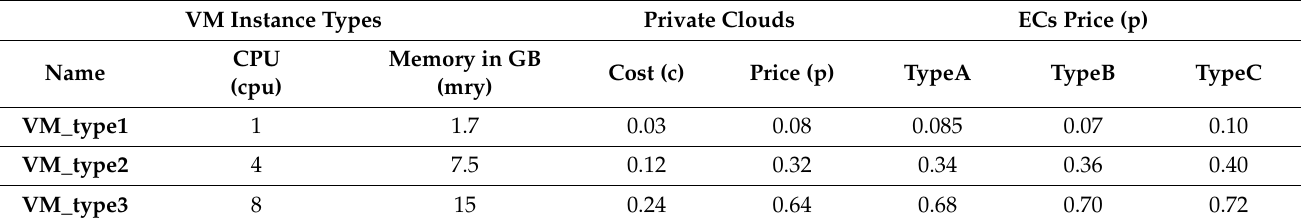
Table 4. Details of the resources.